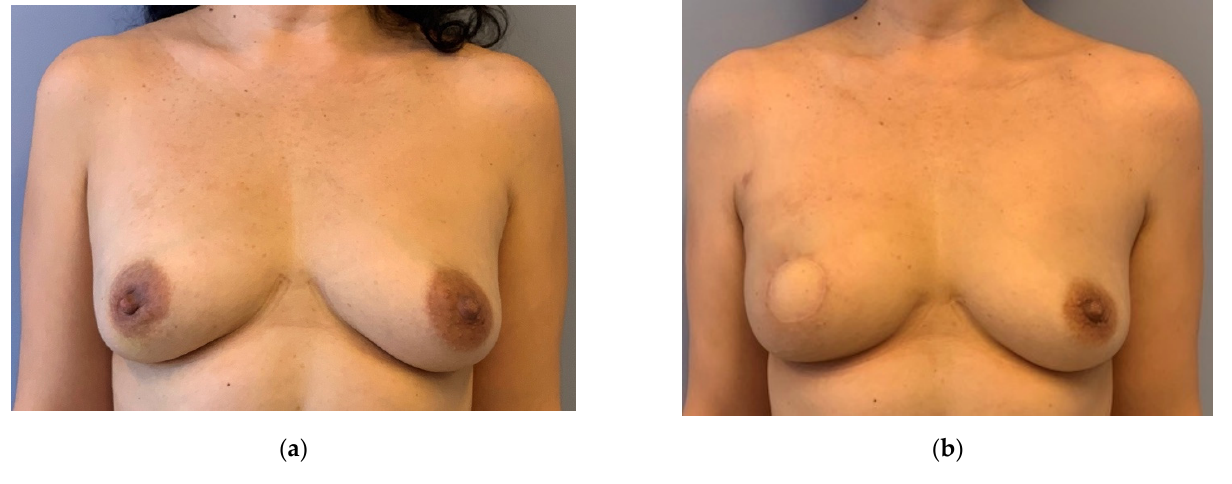
Figure 1. Example of circumareolar SSM. ( a ) Preoperative: 46 years old patient with invasive breast cancer on the right side. She underwent a circumareolar SSM and DIEP-flap reconstruction without NAC reconstruction. ( b ) Postoperative: 6 months after surgery and radiation therapy. The skin island replaces the areola. No other scars on the breast.